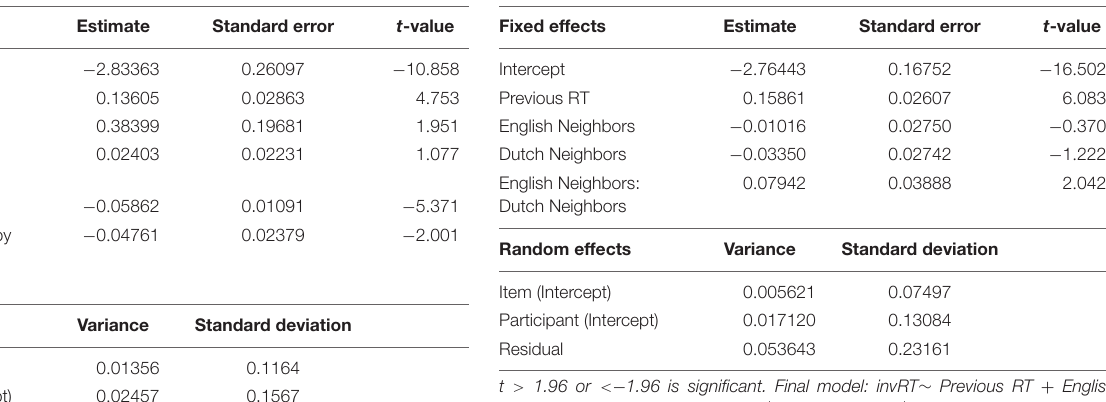
TABLE 4 | Final model for the word data in Experiment 1 (English Lexical Decision with neighbors).